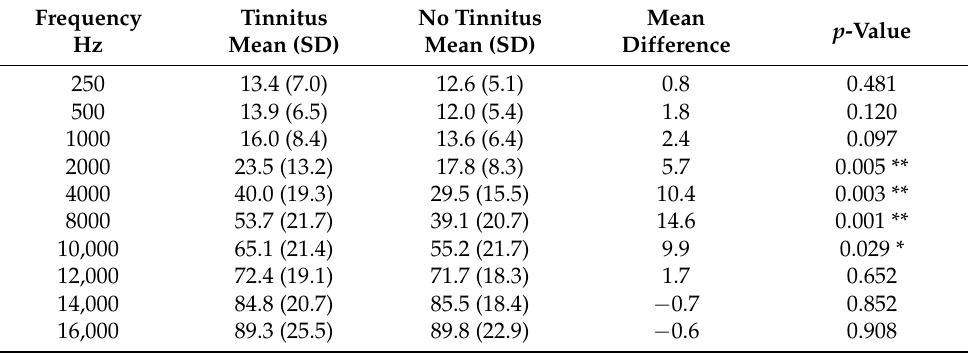
Table 6. Mean and standard deviation of hearing thresholds for the average of both ears. Frequency Tinnitus Hz Mean